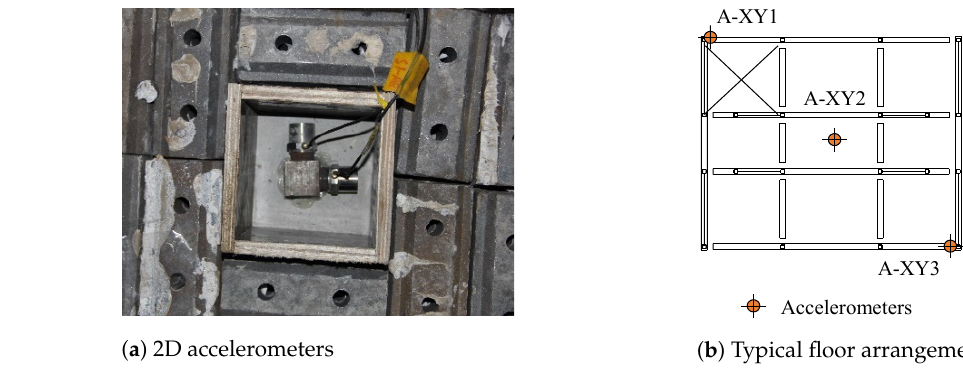
Figure 5. Sensors